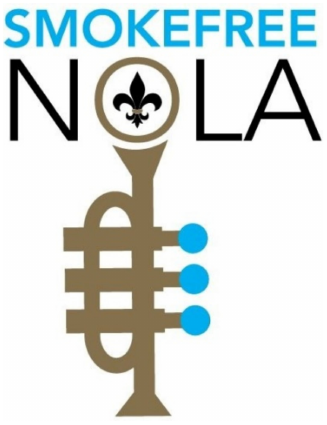
Figure 1. Smokefree NOLA Campaign Logo used the fleur-de-lis, a symbol of New Orleans’ French origins, and a trumpet, reflecting the city’s jazz